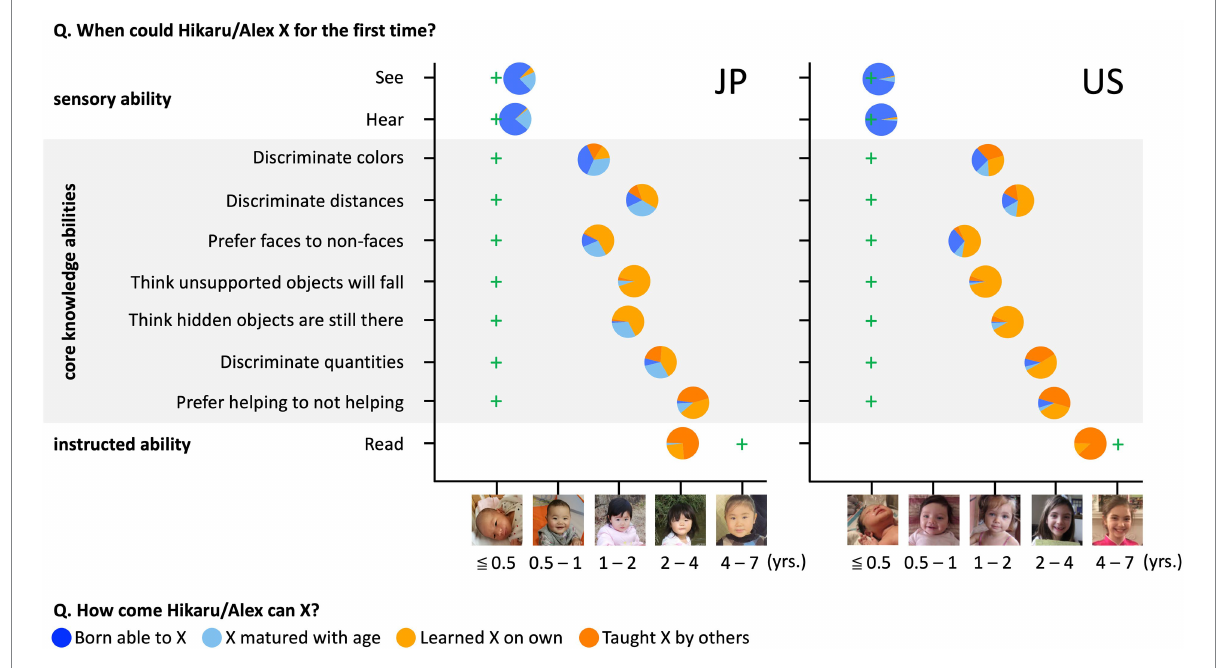
FIGURE 1 Methods and results for Study1A. Circles’ left–right positions represent participants’ age estimates. Circles’ colors represent the distribution of free responses. Green crosses indicate the earliest age category at which abilities have been documented in published